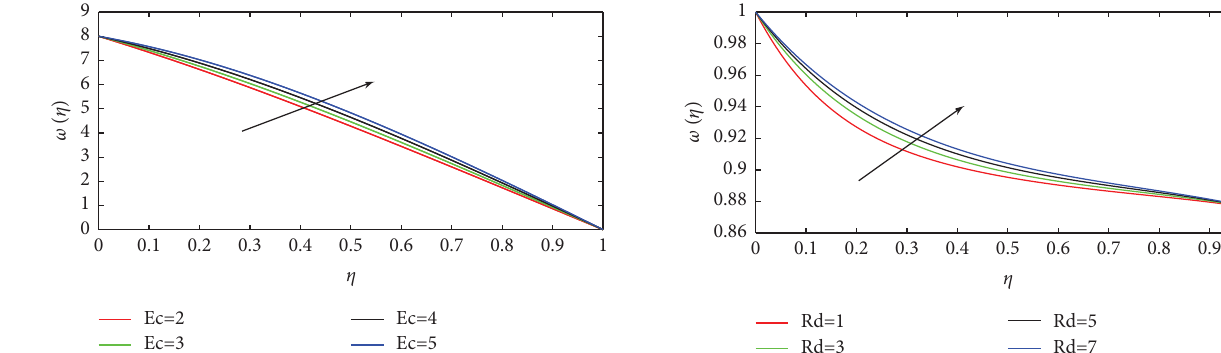
Figure 12: Temperature profles for the diferent values of Ec. Figure 13: Temperature profles for the diferent values of Rd.